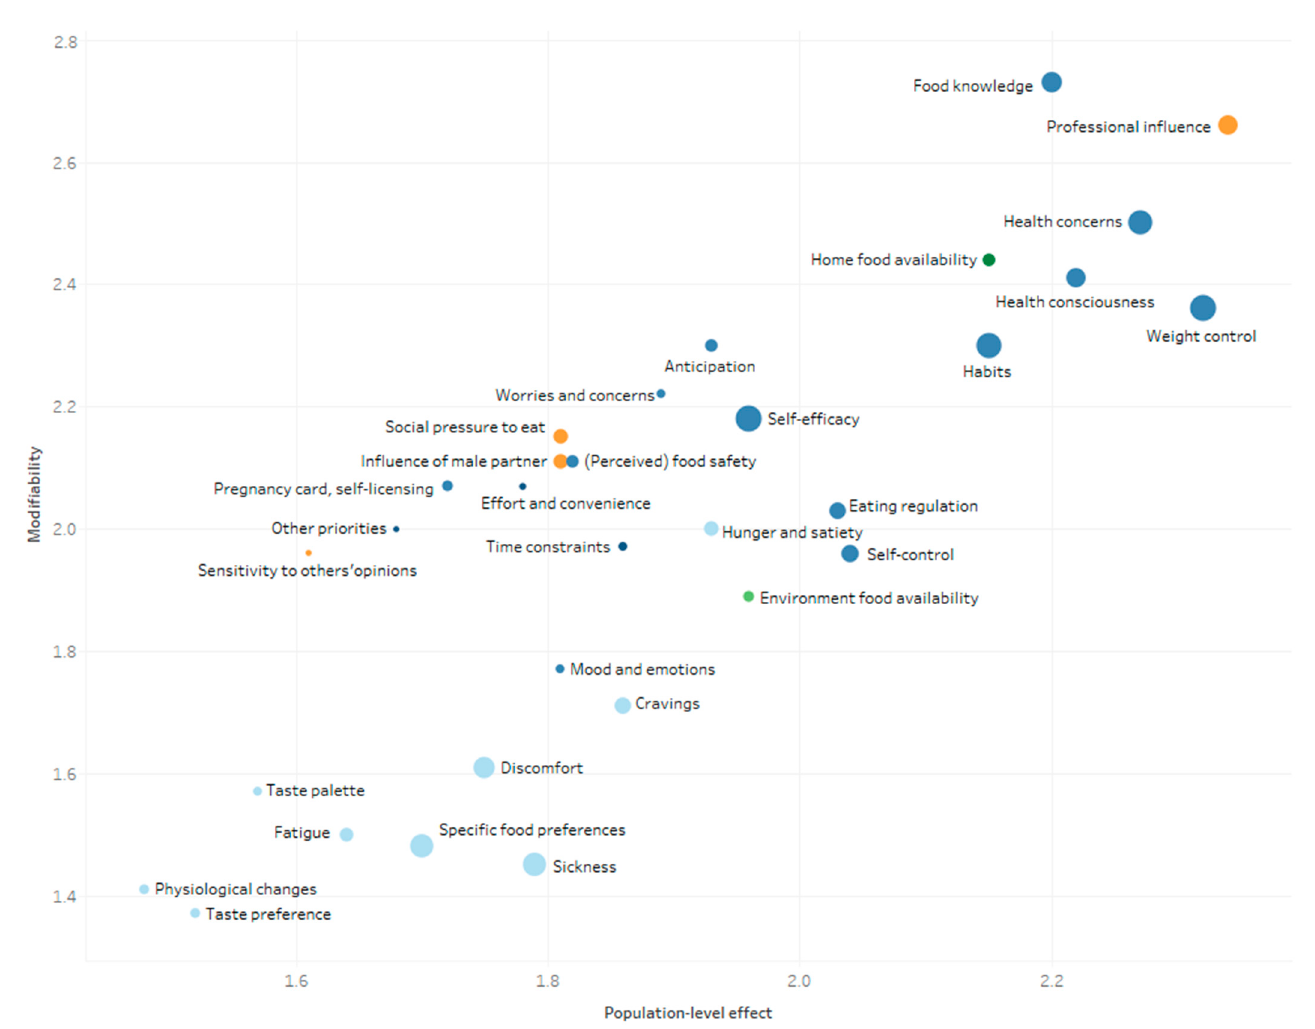
Figure 4. Expert ratings on modifiability, relationship strength, and population-level effect of women’s determinants during pregnancy.